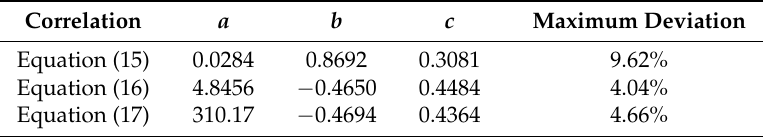
Table 3. Predicted values and deviations of the correlations.